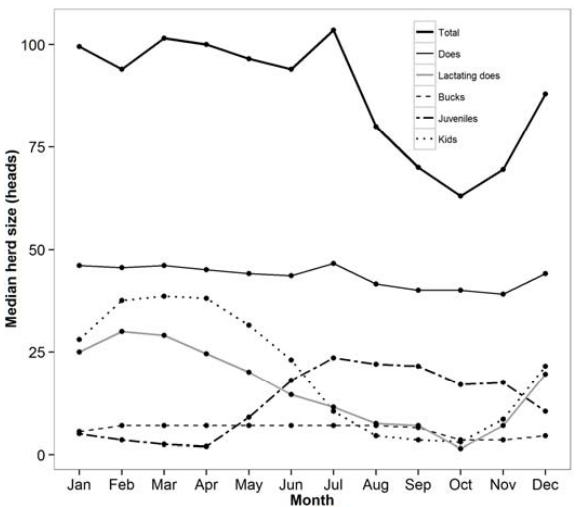
Figure 1. Median herd size of goat holdings in northern Morocco based on monthly data collections between September 2009 and August 2012.